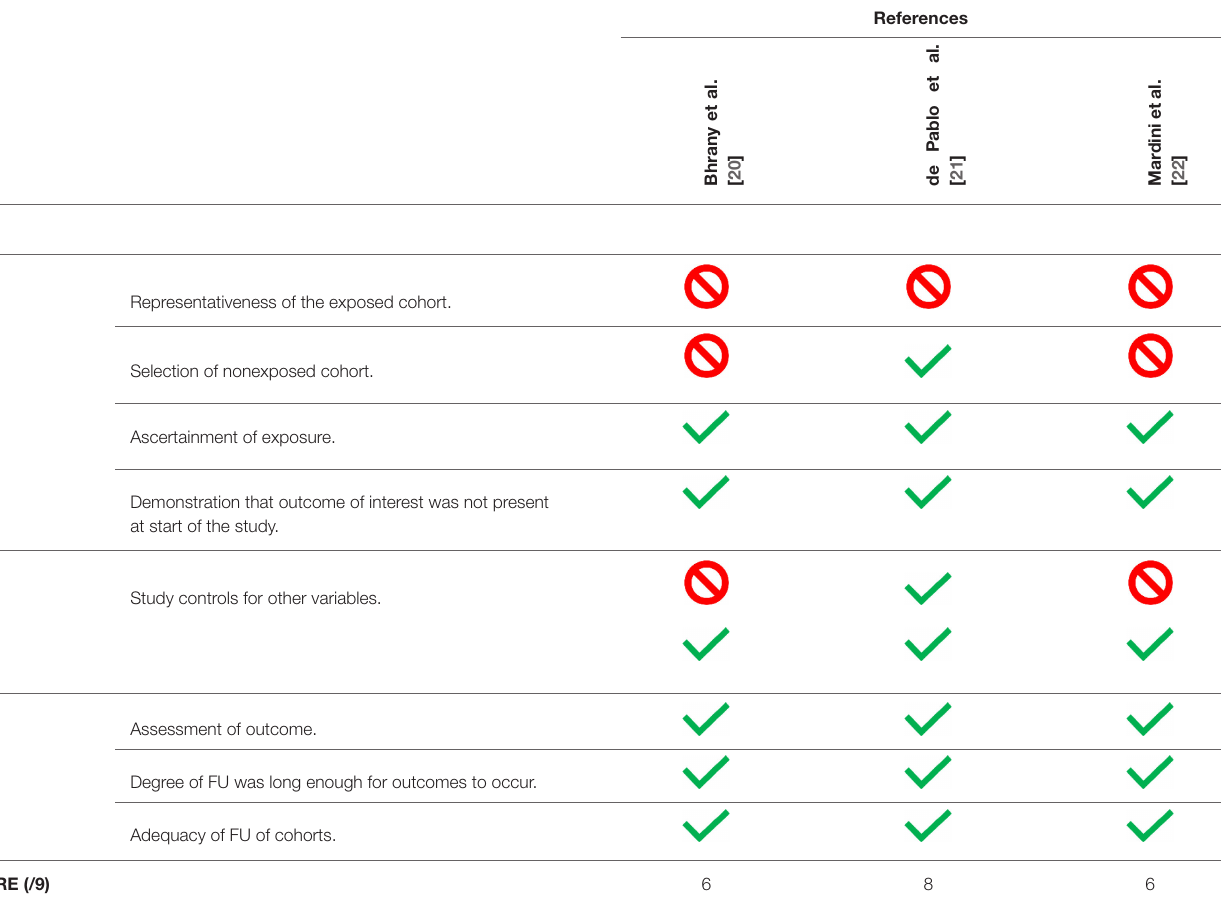
TABLE 1 | Quality assessment according to the Newcastle-Ottawa quality assessment